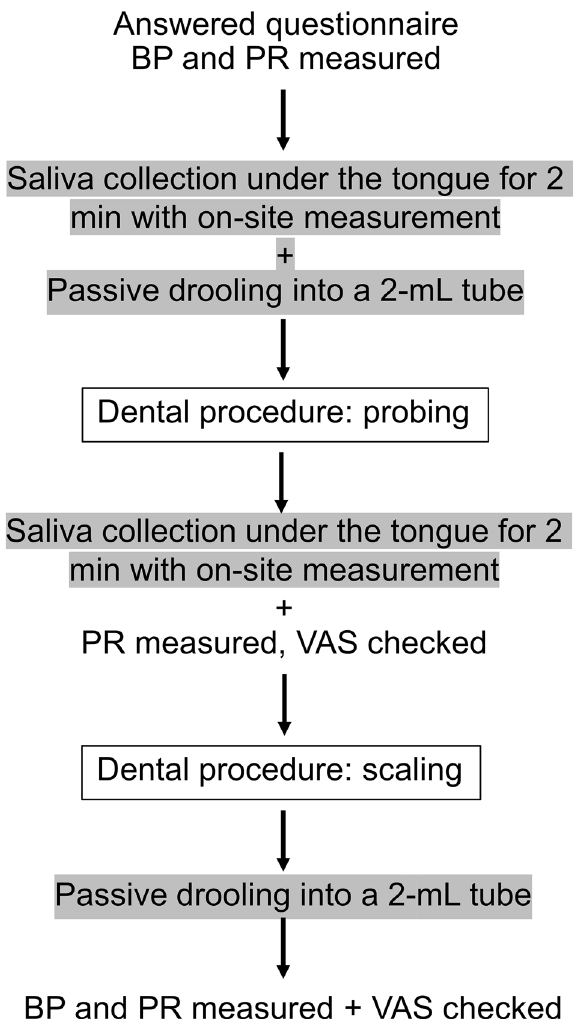
Figure 4. A diagram detailing the protocol. BP, blood pressure; PR, pulse rate; VAS, visual analog